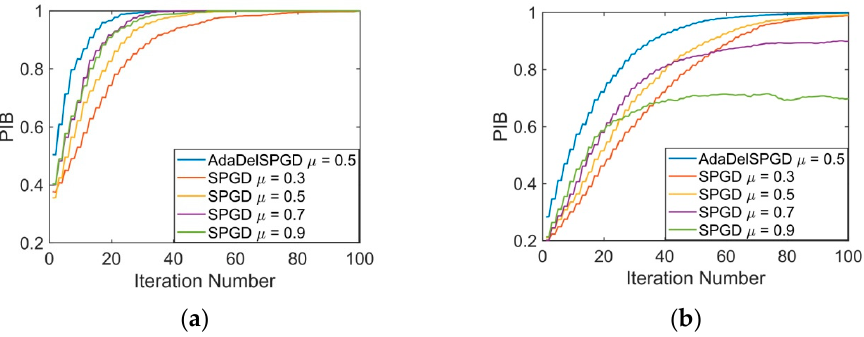
Figure 3. The changes in systematic performance with the number of iterations of two algorithms. ( a ) three-channel; ( b ) seven-channel. Notably, the convergence speed of AdaDelSPGD algorithm is less affected by the gain coefficient than that of traditional SPGD algorithm. Since the adaptive gain coefficients weaken the influence of initial gain on the convergence of the algorithm, the optimal interval of the initial gain coefficients for different channels is almost constant